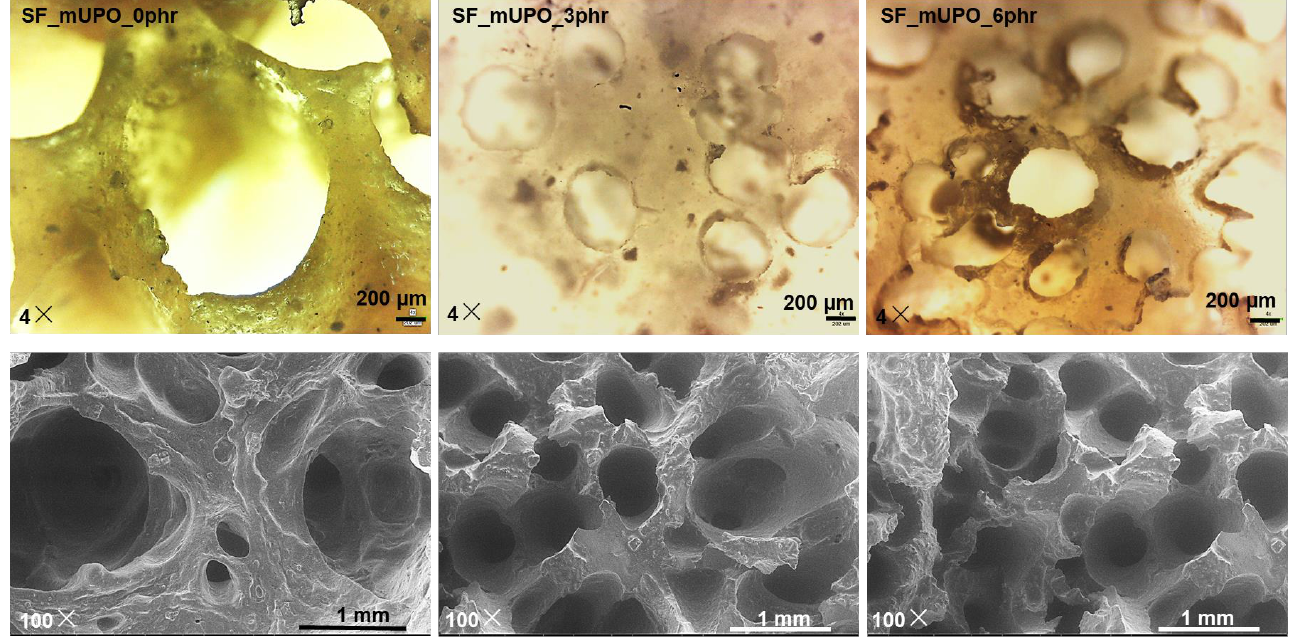
Figure 6. Optical microscope images with a magnification of 4× (upper) and SEM images with a magnification of 100× (lower) of non-glutinous starch foam with various mUPO content — 0, 3, and 6 phr.